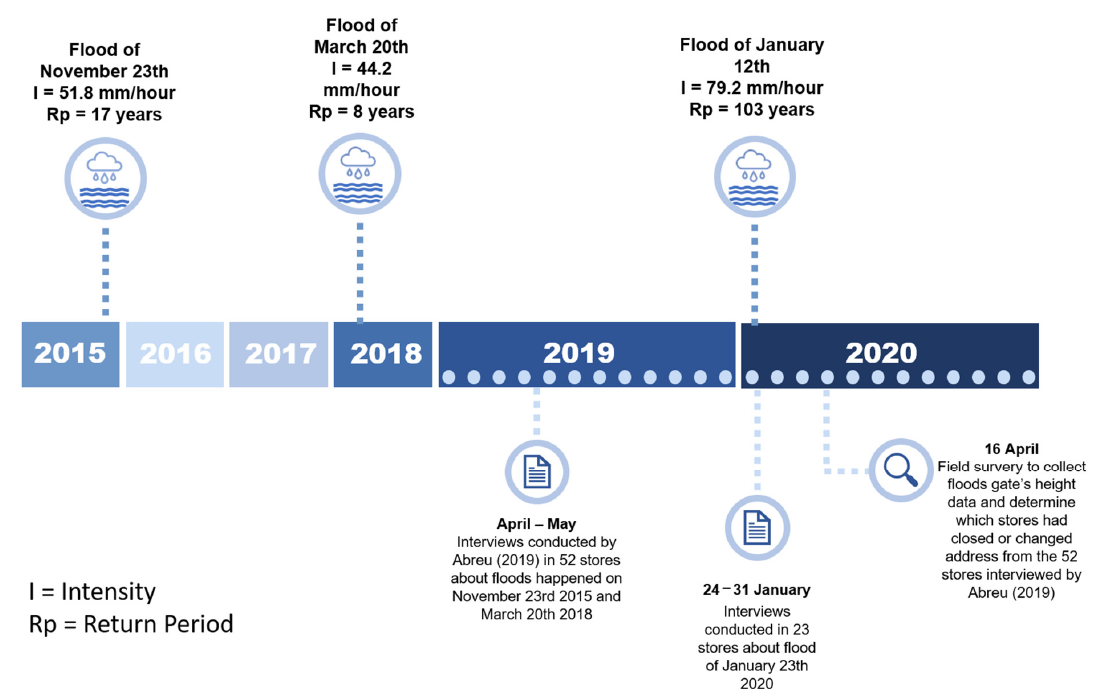
Figure 3. Timeline of floods considered, and the interviews and field survey conducted.